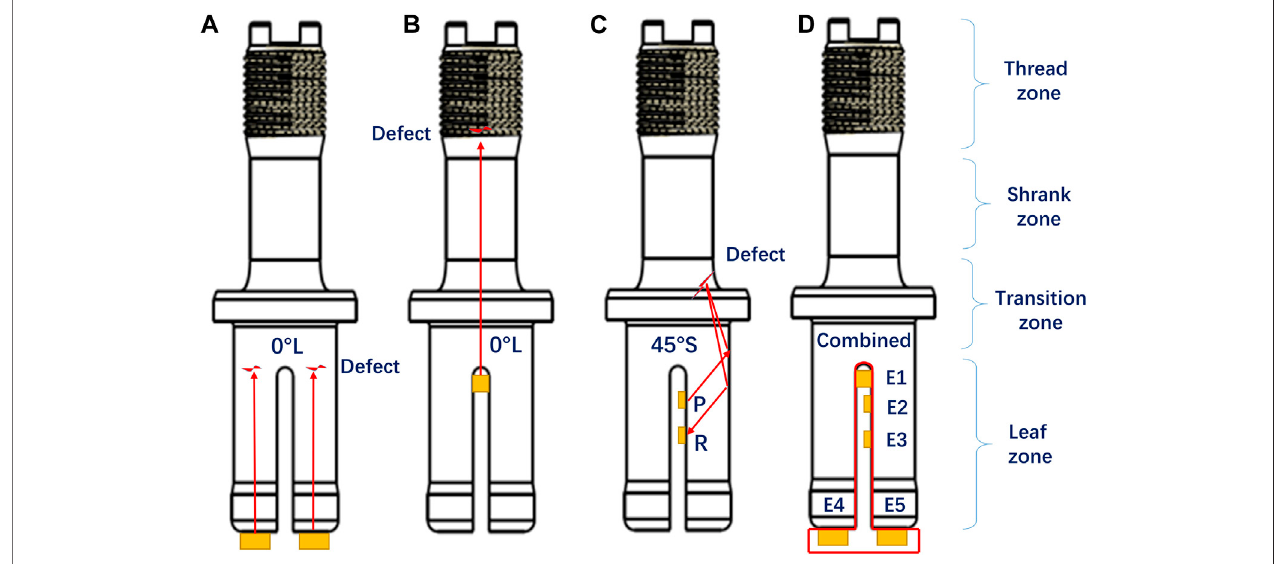
FIGURE 2 | Ultrasonic inspection strategies: (A) 0 ° L for leaf zone; (B) 0 ° L for thread zone; (C) 45 ° S for transition zone; (D) combined design.